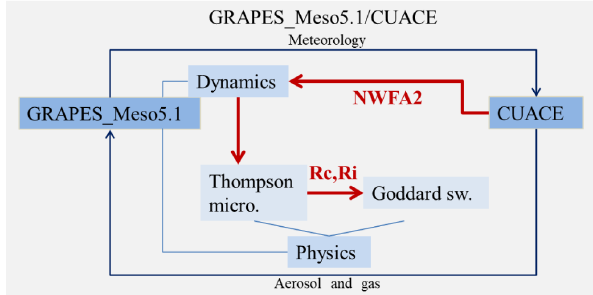
Figure 2. Diagram of aerosol–cloud interaction in the GRAPES_Meso5.1/CUACE model.